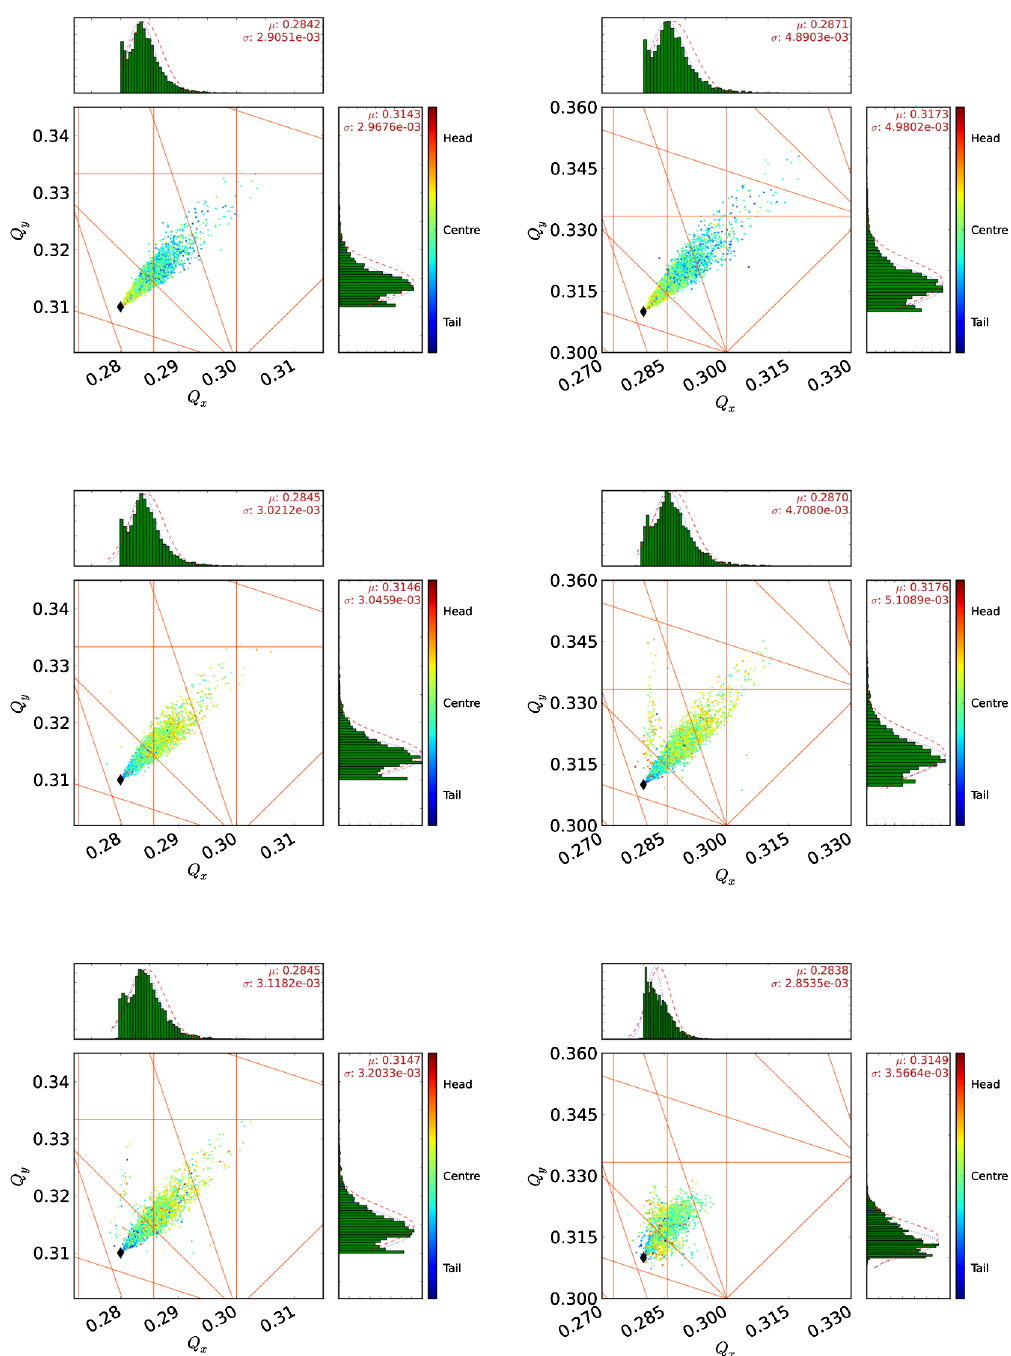
FIG. 19. Tune footprint snapshots in a straight section at 450 GeV after 1 = 6 (top), 1 = 2 (middle), and 3 = 2 (bottom) synchrotron periods. Left: Below the instability threshold ( (cid:6) c ¼ 2 : 2 (cid:2) 10 11 m (cid:1) 3 , n b ¼ 1 : 15 (cid:2) 10 11 ppb ). Right: Above the intensity threshold ( (cid:6) c ¼ 3 : 7 (cid:2) 10 11 m (cid:1) 3 , n b ¼ 1 : 15 (cid:2) 10 11 ppb ). Resonance lines up to 11th order have been